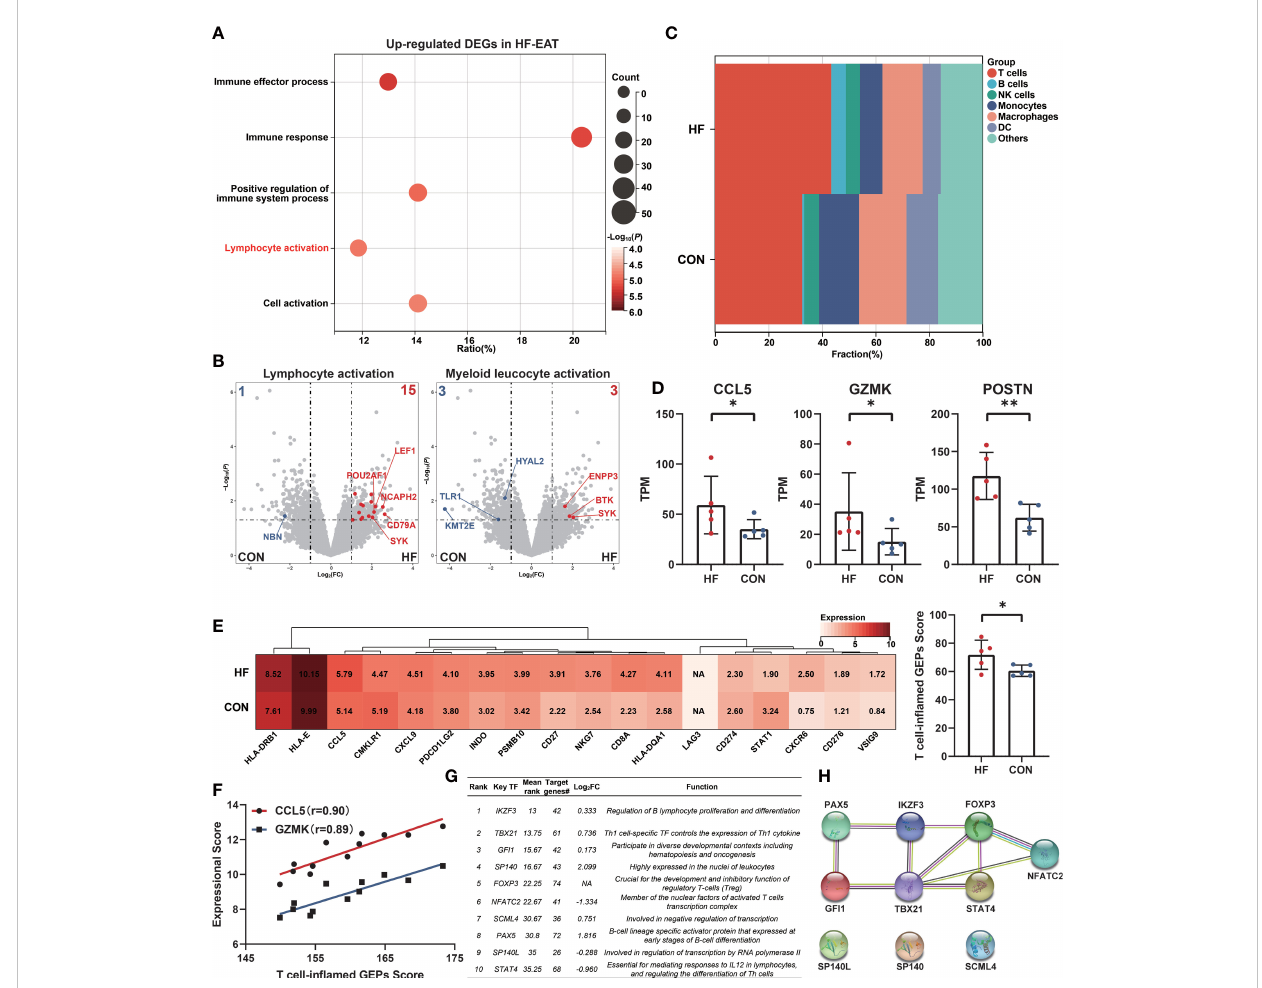
FIGURE 4 Ampli fi ed lymphocyte activation features in EAT of HF patients. (A) GO-BP functional enrichment analyses of up-regulated DEGs in EAT of HF patients. (B) “ Lymphocyte activation ” and “ myeloid leucocyte activation ” GO term genes in DEGs of HF-EAT. (C) Immune cell in fi ltration analyses of HF-EAT and control EAT by CIBERSORT. (D) Differentially expressed key genes in HF-EAT. (E) Expression of T cell-in fl amed GEPs in HF-EAT and control EAT. (F) Correlation of CCL5 and GZMK expression with T cell-in fl amed GEPs score in GSE24425. (G) Top 10 potential key TFs of DEGs in HF-EAT identi fi ed by ChEA3 database. (H) PPI network of top 10 potential TFs. * P < 0.05, ** P <